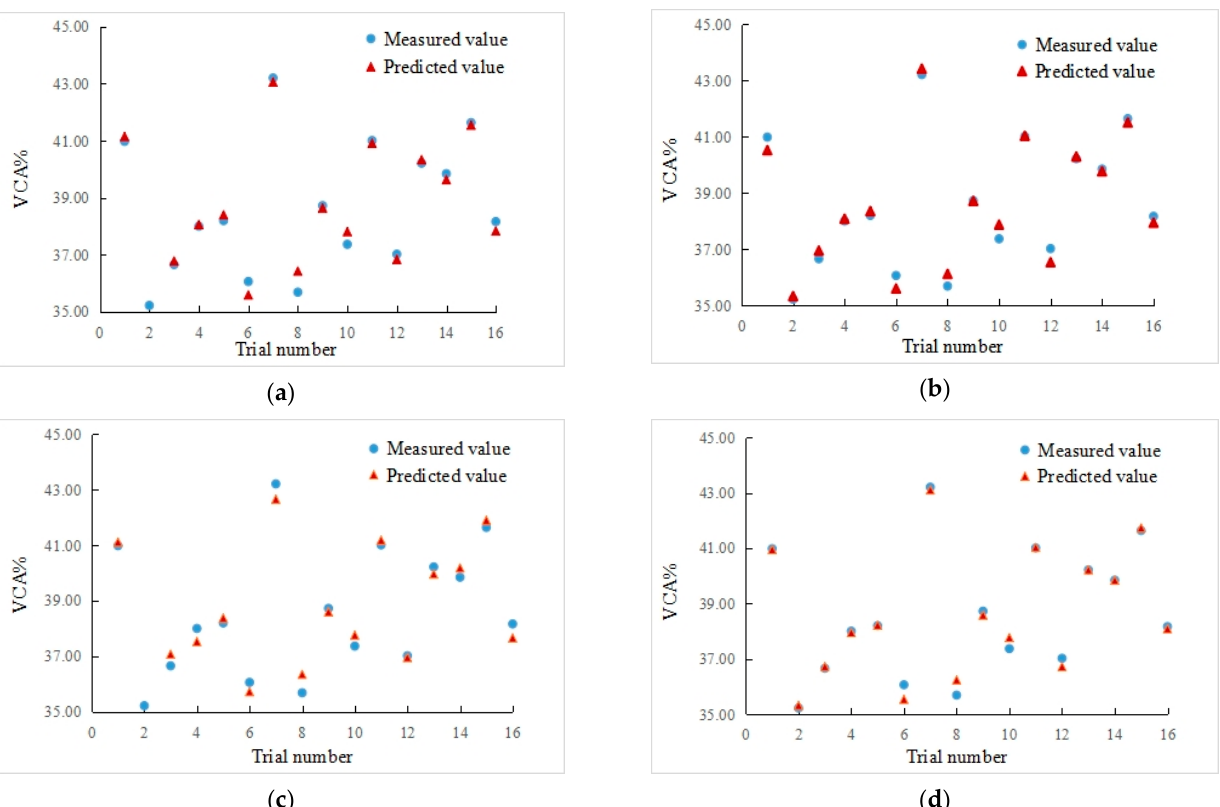
Figure 3. Comparisons between the measured and predicted values for each model: ( a ) regression Equation (4), ( b ) regression Equation (5), ( c ) regression Equation (6), and ( d ) regression Equation (7). Table 4. Analytical parameters of regression equations.